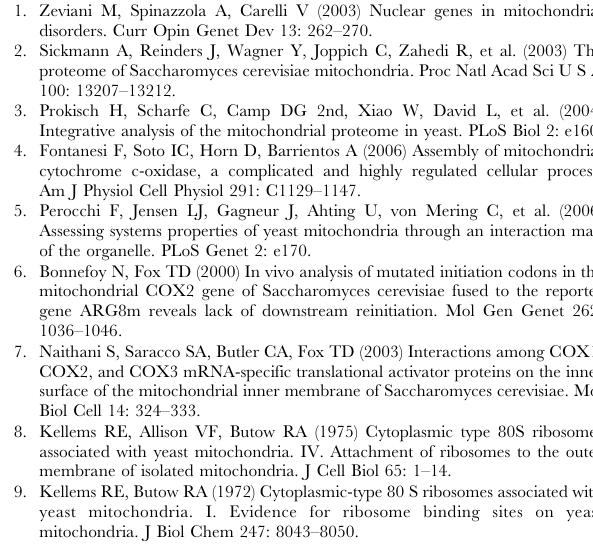
target signifies that the corresponding mRNA has been retained in affinity chromatography with Puf3p (Gerber AP, Herschlag D, Brown PO (2004) PLoS Biol 2: E79). Table S2 RT-PCR analyses of mRNA localization. RT-PCR analyses were conducted as indicated in Garcia M, Darzacq X, Devaux F, Singer R, Jacq C (2007); Biology MiM, editor. Totowa, New Jersey: Humana Press. 505–528 p. Table S3 The COX assembly factors are class I MLR-mRNAs. The different classes of genes were described previously (Fontanesi F, Soto IC, Horn D, Barrientos A (2006) Am. J. Physiol. Cell 291:C1129–1147). All the assembly factors are translated to the vicinity of mitochondria and 17 out 18 are likely to interact with Puf3p. The 8 nuclearly-encoded mRNAs coding for structural proteins are translated on free cytoplasmic polysomes. Table S4 List of the genes coding for cytosolic non-mitochon- drial proteins (according to YPD) which were used as a negative control set Found at: doi:10.1371/journal.pone.0002293.s011 (0.07 MB XLS) Doc S1 QUANTITATIVE PCR ANALYSIS OF ASYMMET- RIC mRNA LOCALIZATION. Found at: doi:10.1371/journal.pone.0002293.s012 (0.18